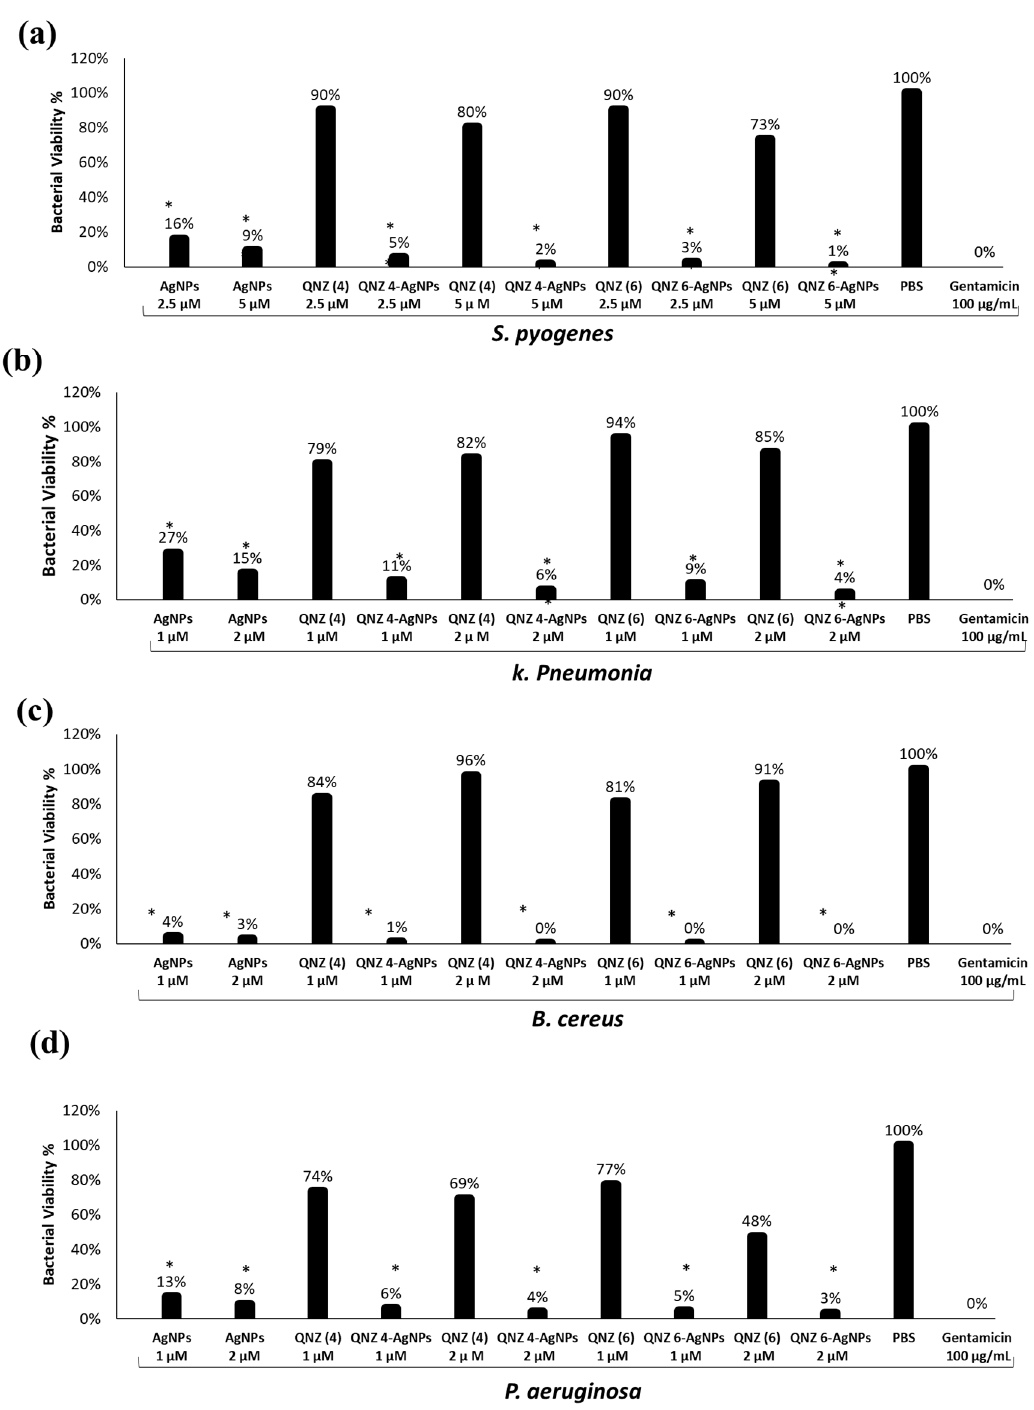
Figure 7. Antibacterial activities of quinazolinone nanoparticles against multi-drug resistant bacteria. ( a ) Bactericidal effects of QNZ 4-AgNPs and QNZ 6-AgNPs at (2.5, 5) µM against S. pyogenes. ( b ) Bactericidal effects of QNZ 4-AgNPs and QNZ 6-AgNPs at (1, 2) µM against K. pneumonia. ( c ) Bactericidal effects of QNZ 4-AgNPs and QNZ 6-AgNPs at (1, 2) µM against B . cereus. ( d ) Bactericidal effects of QNZ 4-AgNPs and QNZ 6-AgNPs at (1, 2) µM against P . aeruginosa. Notably, nanoparticles showed significant effects at both concentration against both S . pyogenes and K . pneumonia comparing with bacteria alone and lower bacterial viability as compare to AgNPs alone. Also, the nanoconjugates displayed minimal bactericidal effects against B . cereus and P . aeruginosa compared with AgNPs. The results are presented as the mean ± standard error of various experiments performed in duplicate. * indicates p < 0.05 using two-sample t test and two-tailed distribution.